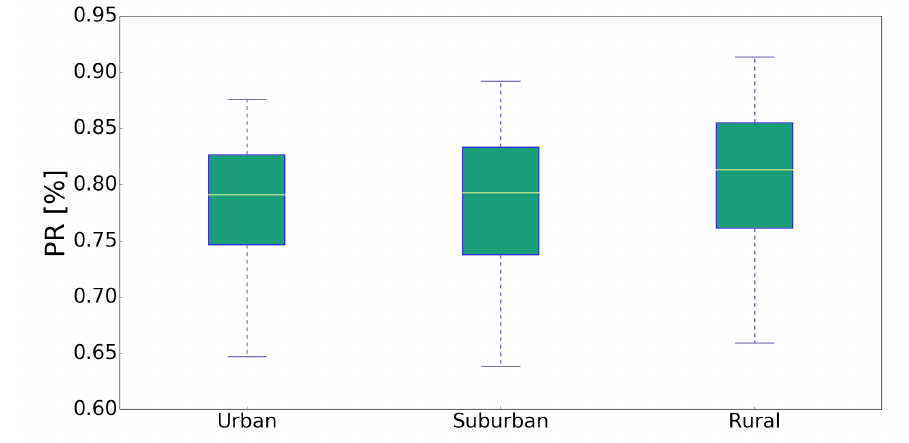
Figure 5. Boxplots of annual PR distribution for